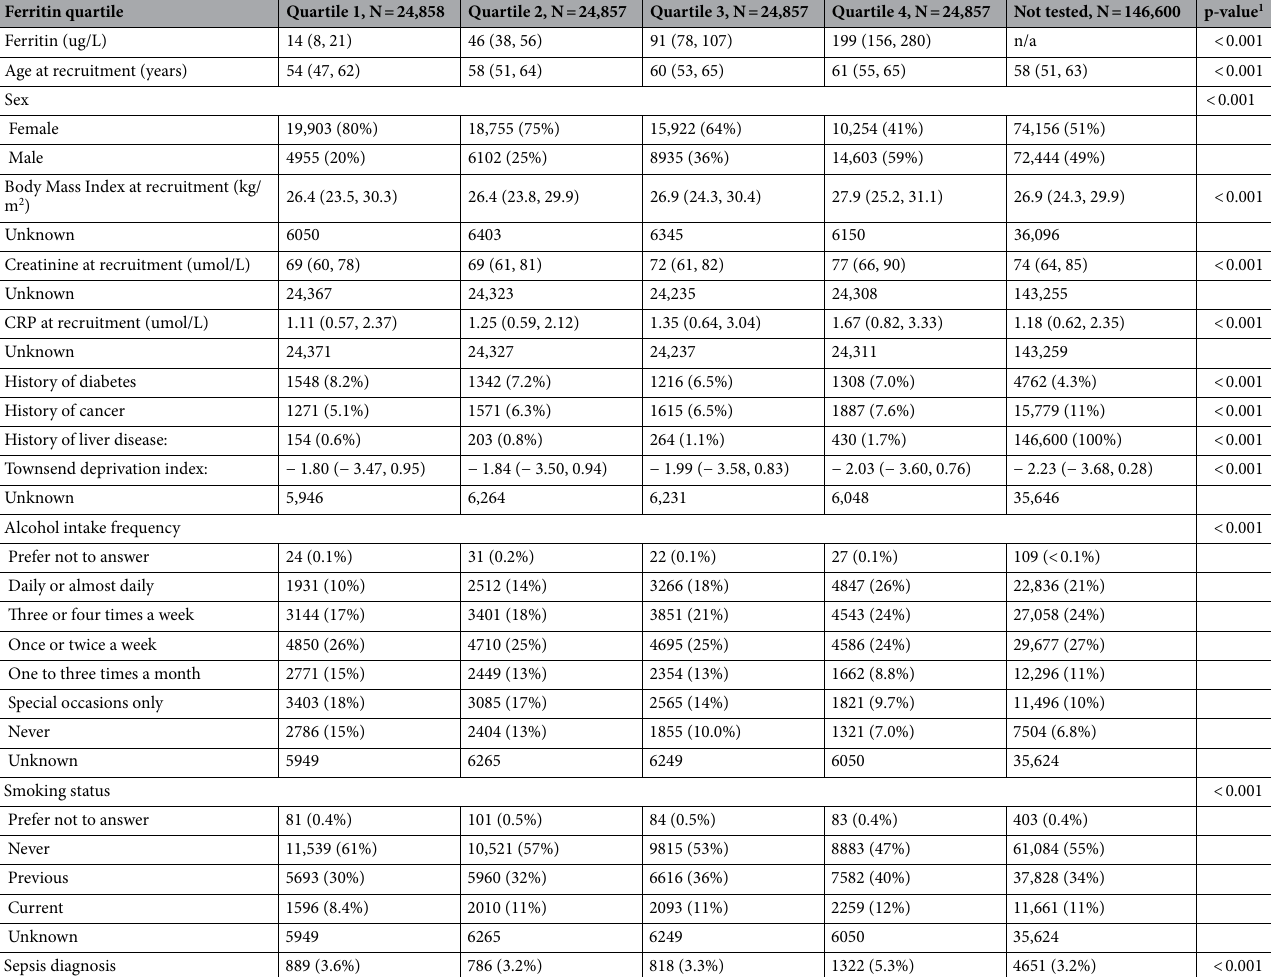
Table 1. Associations between ferritin testing status and level on potential confounders. 1 Median (IQR); n (%); Kruskal–Wallis rank sum test; Pearson’s Chi-squared